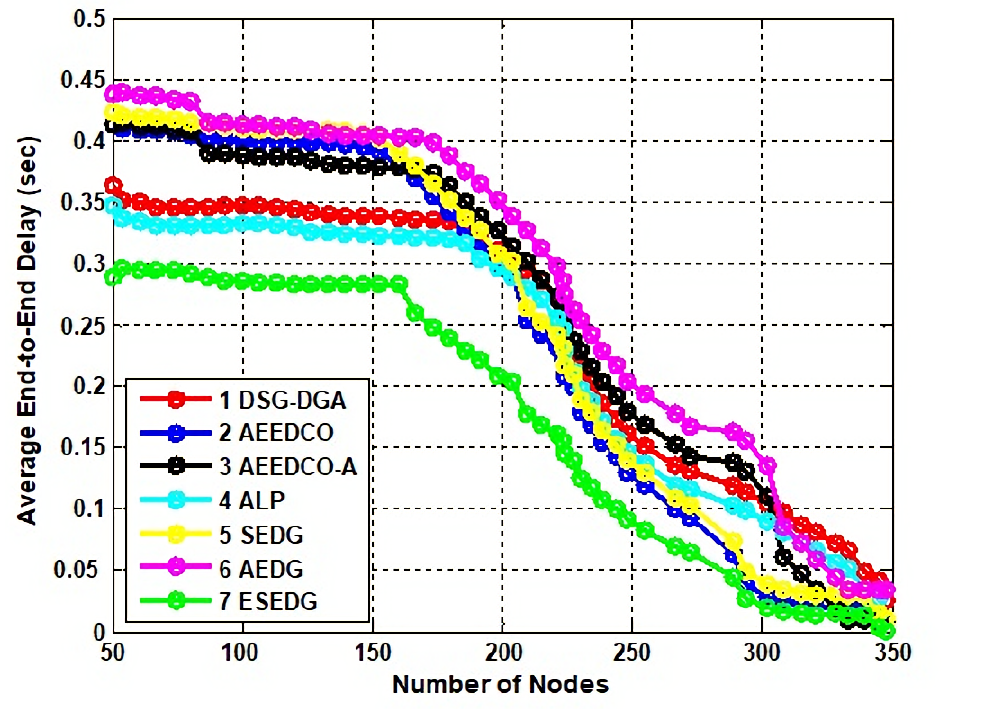
Figure 5. Analysis of E2E delay with baseline